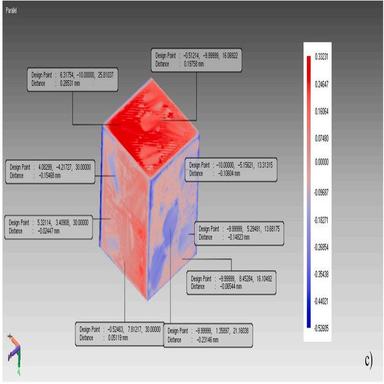
W14 cube: a) and b) variances distribution from two view points; c) punctual variances.